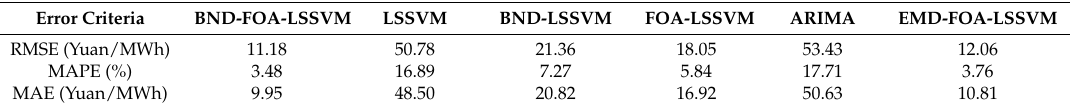
Table 3. Forecasting performances of different methods. Auto-regressive integrated moving average (ARIMA); empirical mode decomposition (EMD); mean absolute percentage error (MAPE); root mean square error (RMSE); mean absolute error